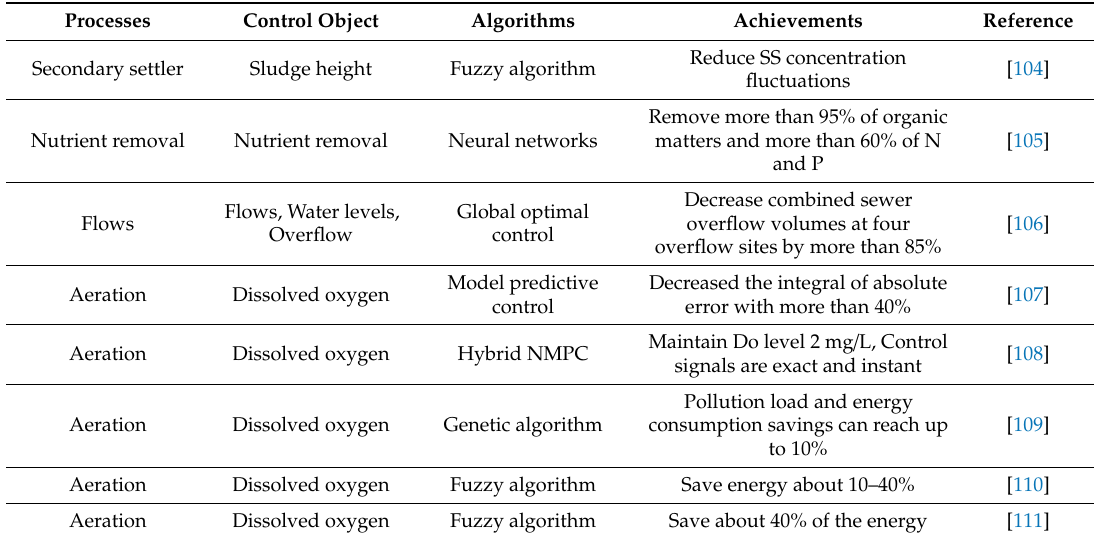
Table 5. Some examples of using optimization algorithms to adjust di ff erent control